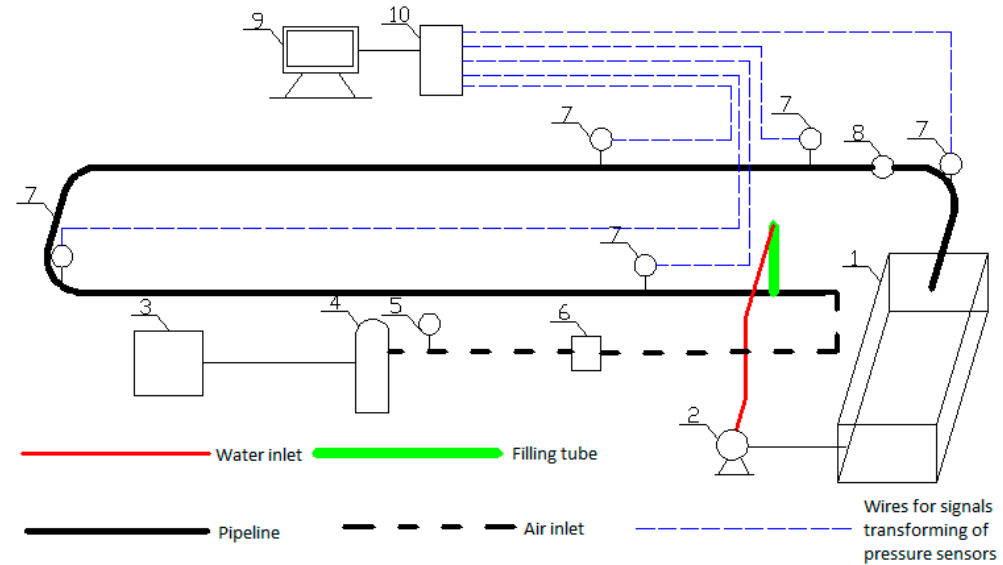
Figure 1. Two-phase pulse flushing experiment set up: (1) water tank; (2) water pump; (3) wir compressor; (4) gasholder; (5) pressure control valve; (6) pulse generator; (7) pressure transmitter; (8) flow meter; (9) computer; and (10) data acquisition module.